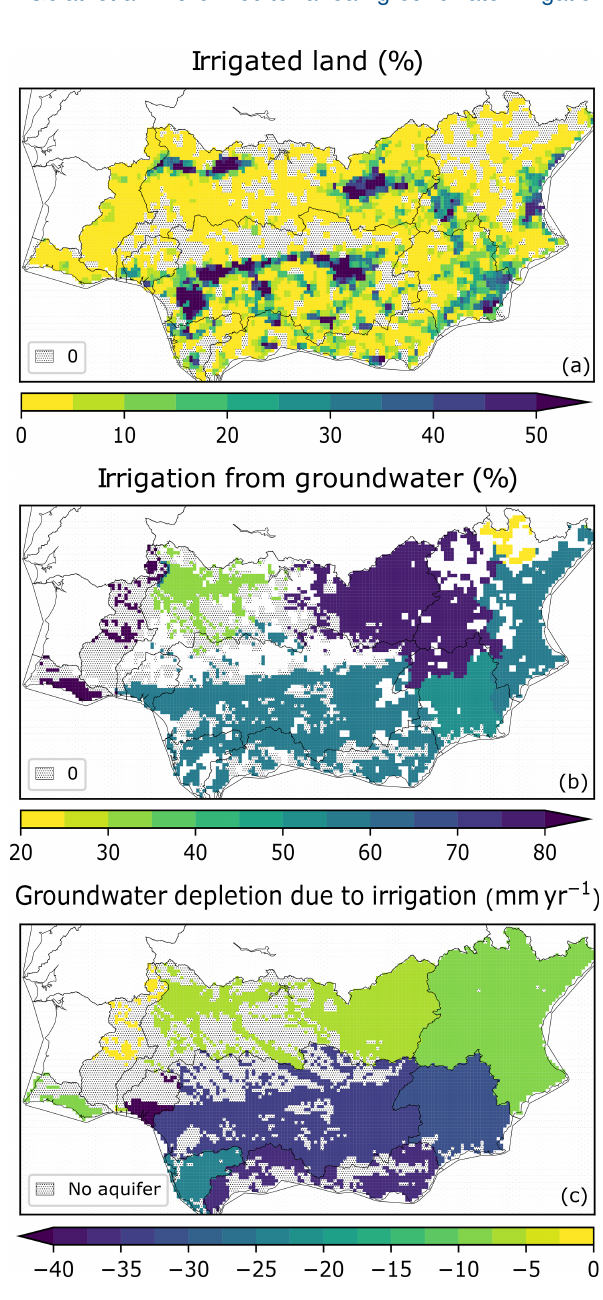
Figure 6. The southern Iberian Peninsula model domain where the regulation of groundwater irrigation is tested: (a) map of the irri- gated area as a fraction of the total area (Sect. 3.3); (b) the share of irrigation water that is abstracted from groundwater as reported by Eurostat (2020c); and (c) groundwater depletion due to irrigation as simulated by LISFLOOD-EPIC (from Fig.